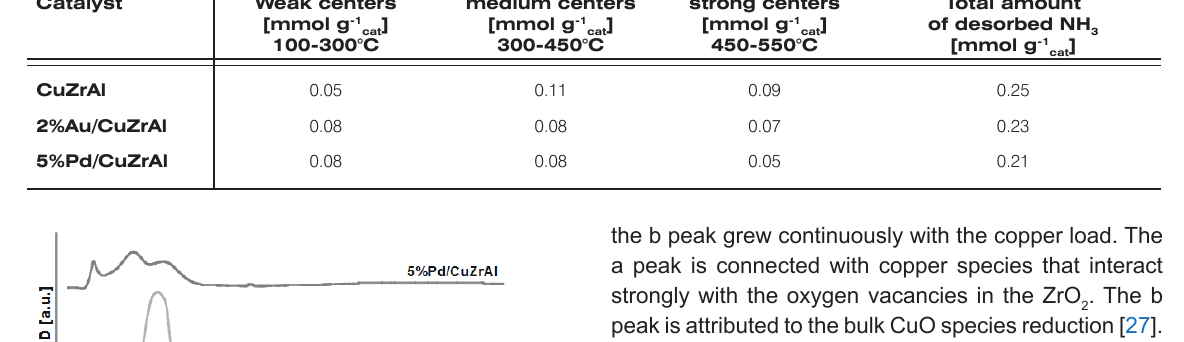
Table 2. Distribution of acid centers for ternary and doped ternary catalysts calcined in air for 3.5 h at 400°C. Catalyst